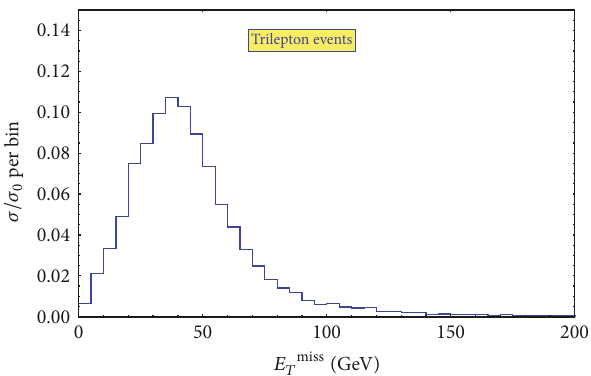
Figure 14: MET distribution from the 3 ℓ + MET final state from pp → 𝑁ℓ𝑋 , 𝑁 → ℓ𝑊 , 𝑊 → ℓ ] at the 13TeV LHC.